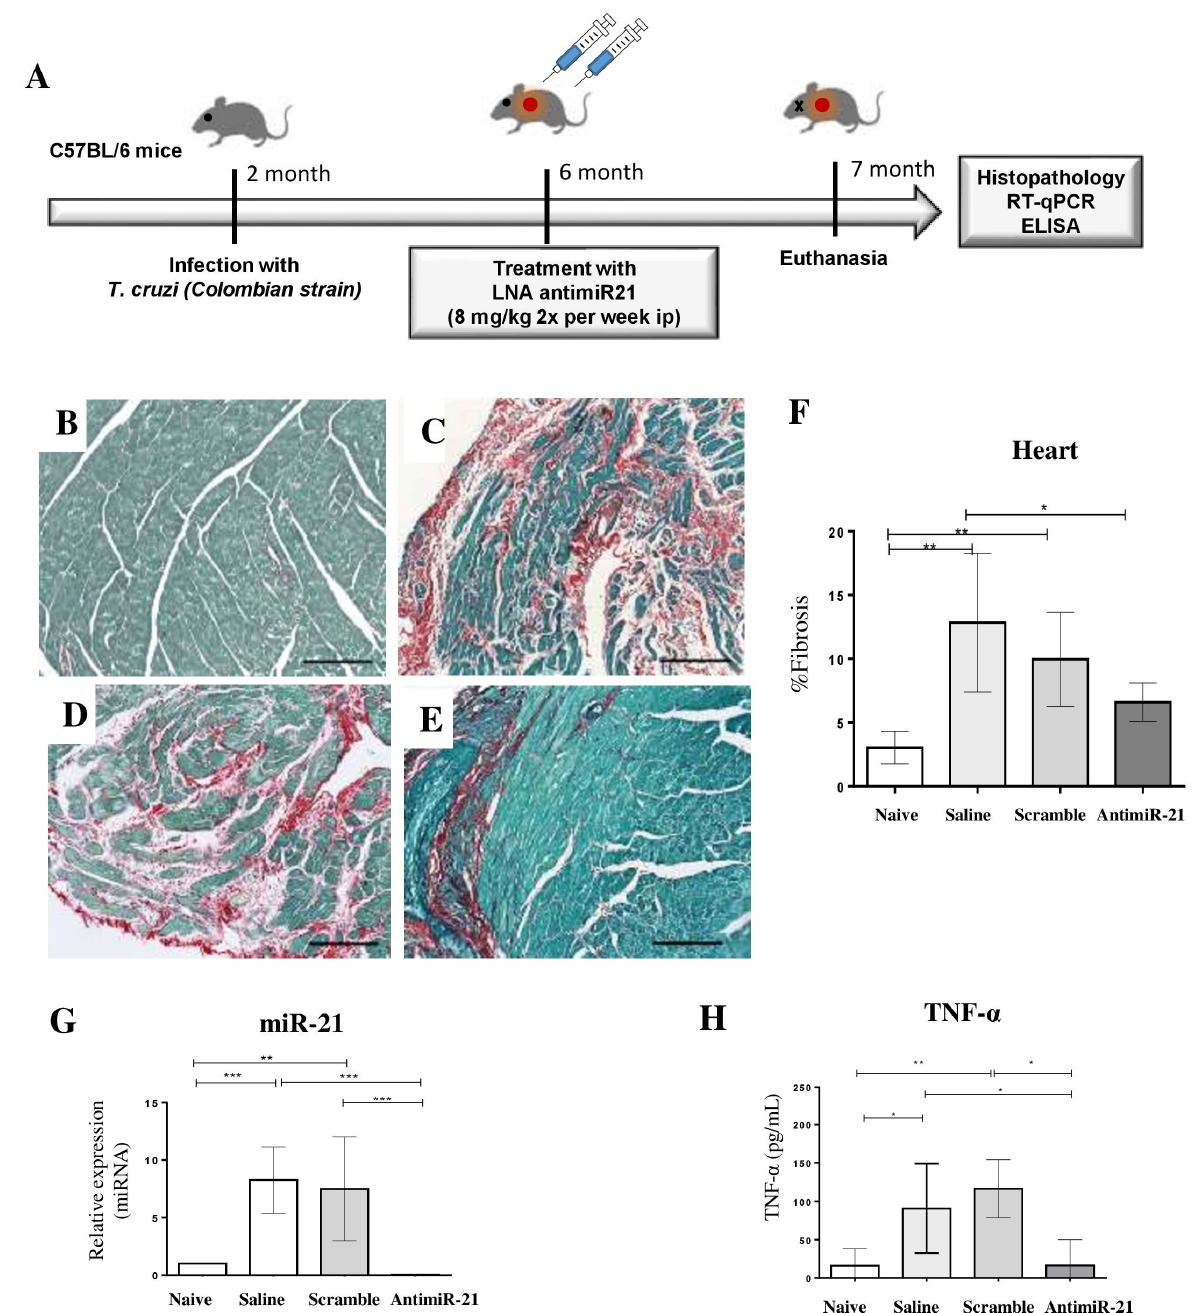
Figure 6. Effects of the treatment with LNA-anti-miR-21 inhibitor in chronic chagasic mice. ( A ) Experimental design of the in vivo experiments. ( B – E ) Representative images of cardiac sections (ventricles) stained with Sirius Red. The following experimental groups were evaluated: naïve ( B ), saline ( C ), LNA scrambled ( D ), and LNA-anti-miR-21 ( E ). Scale bars = 100 µ m. ( F ) Quantification of fibrosis area. ( G ) Heart samples from mice treated with LNA-miR-21 inhibitor were used to evaluate the miR-21 expression levels by RT-qPCR two weeks after treatment. ( H ) serum levels of cytokine TNF- α evaluated by ELISA. Data are represented as mean ± SEM. n = 8 per group. ANOVA with Bonferroni comparisons. * p < 0.05. ** p < 0.01. *** p <